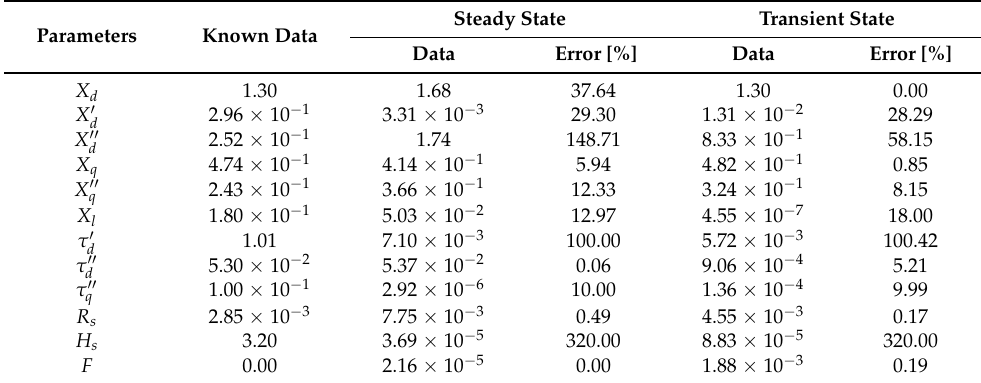
Table 6. Synchronous machine parameters with known and optimized data.